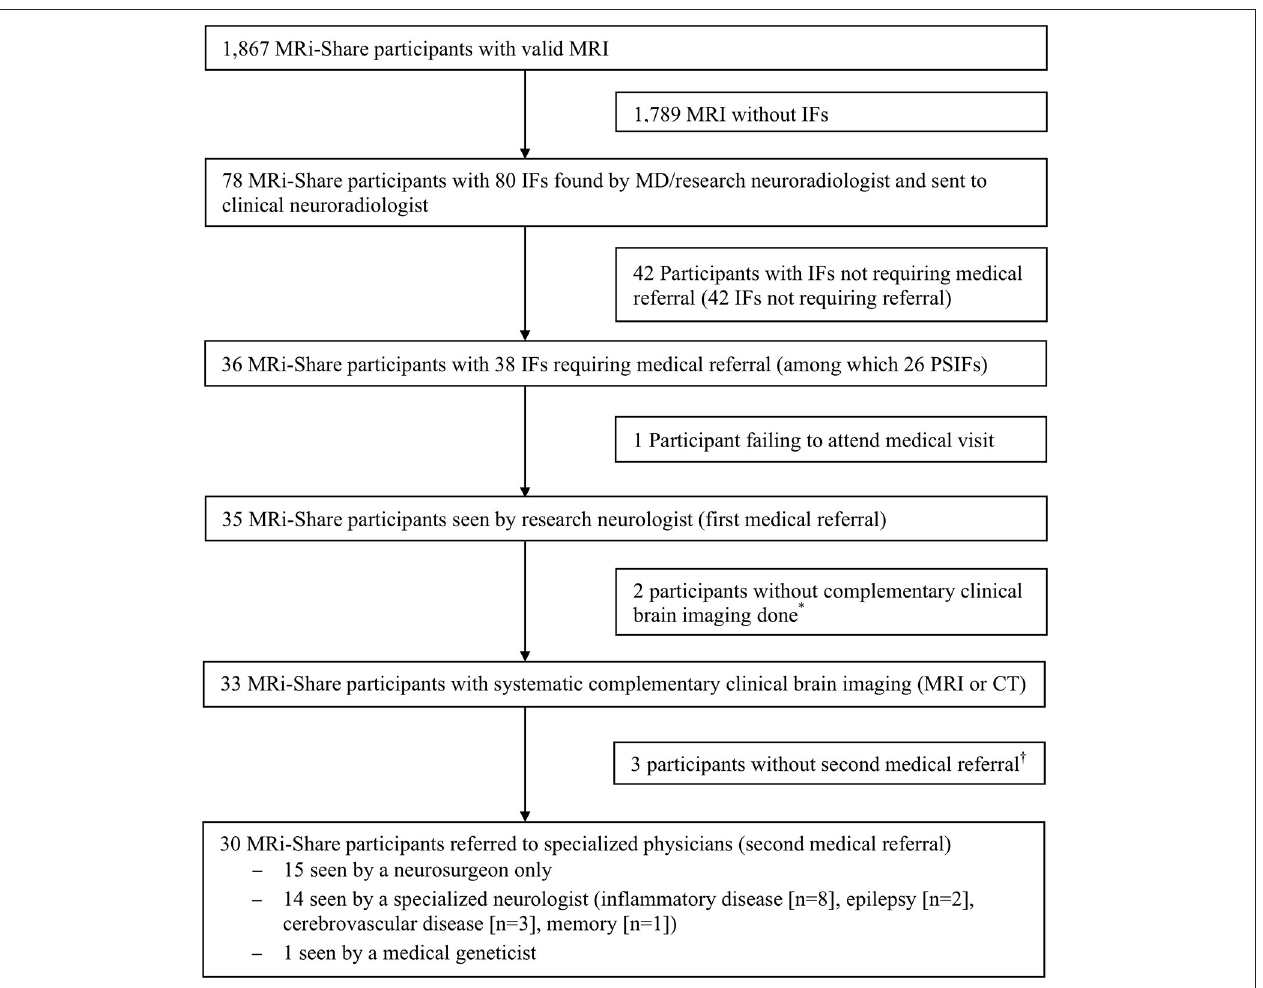
FIGURE 2 | Procedure for detection and management of incidental findings (IFs). MD, medical doctor; PSIFs, potentially serious incidental findings. *Refusal by the participant, n = 1; not necessary (previous reassuring MRI performed prior to i-Share research MRI), n = 1. † Refusal of follow-up visit, n = 2; not necessary, n =